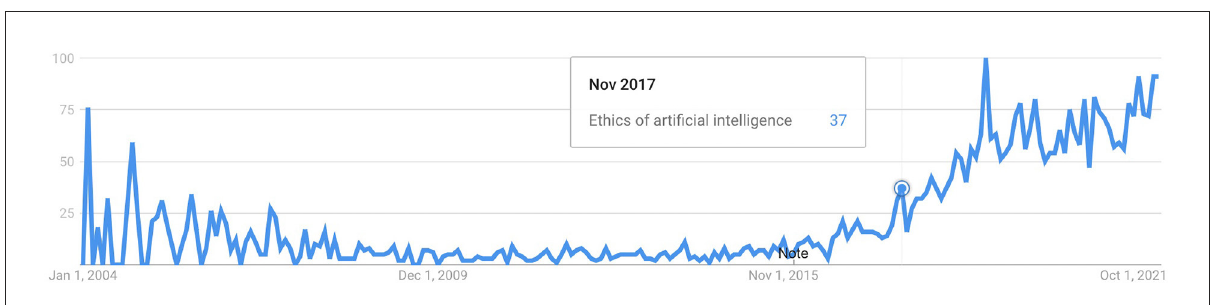
FIGURE3 Interest over time in “Ethics of artificial intelligence.” Source: Google